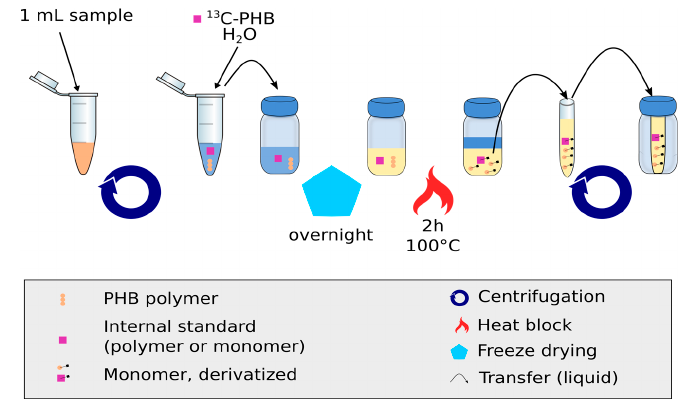
Figure 1. Sample processing steps for the measurement of (PHB) 1 using the IDMS approach. Broth is centrifuged and re-suspended to remove extracellular matrix. After freeze-drying, the sample is further cleaned and